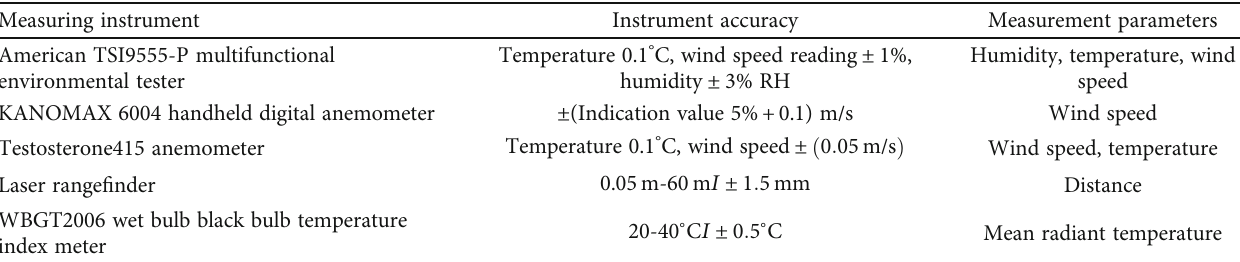
Figure 3: Floor plan of Songyun City community at the test site. Table 1: Instruments and accuracy used for on-site